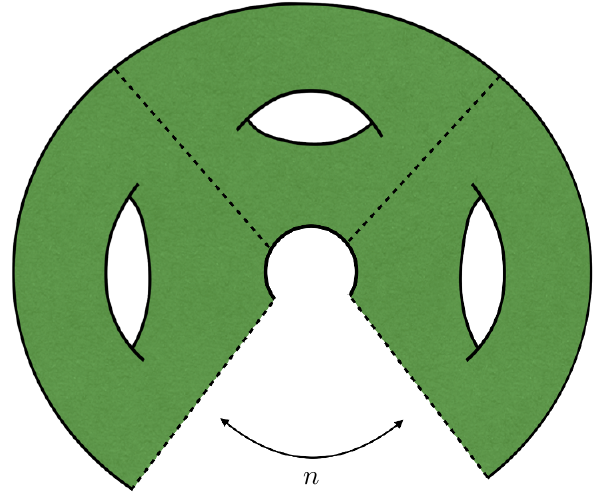
Figure 3 . Partition function of genus n + 1 that computes Tr( T n ) in the